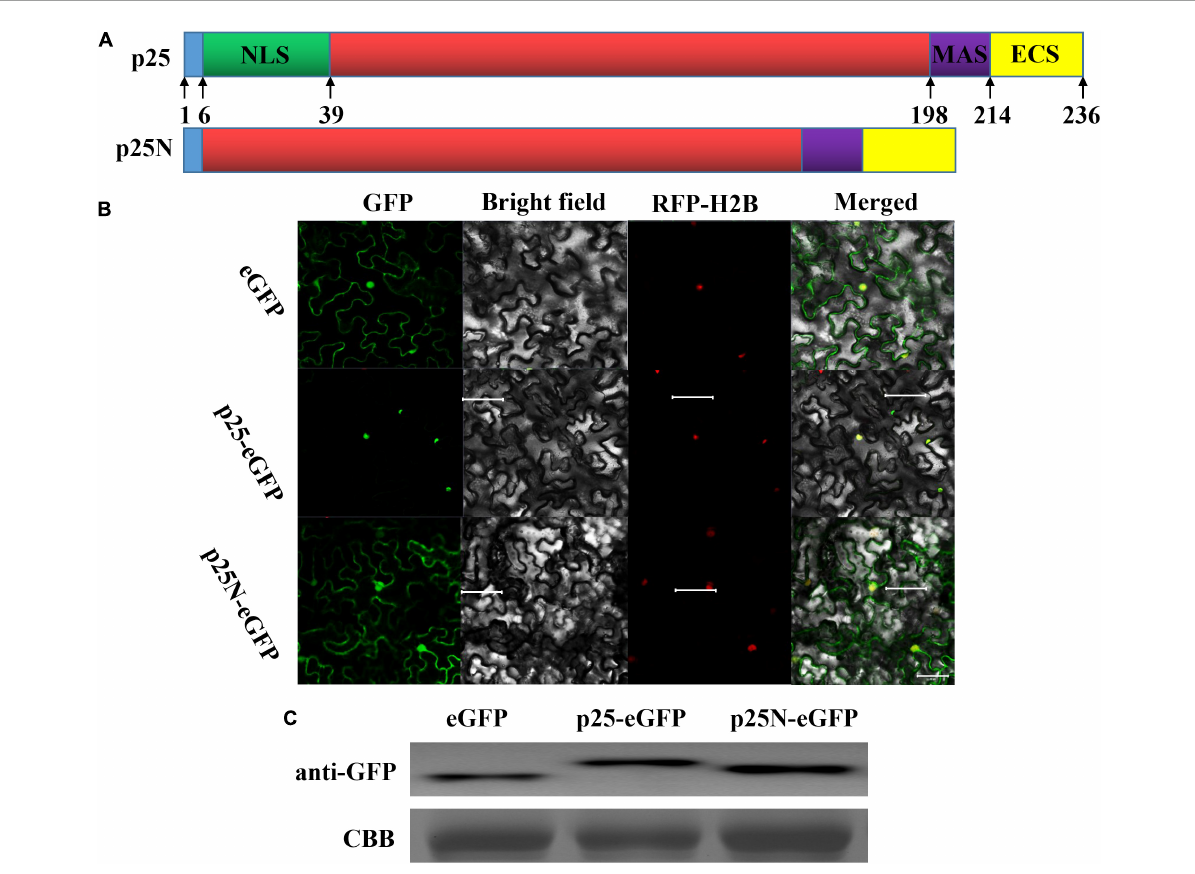
FIGURE3 Subcellular location of p25. (A) Schematic sketch of the construction strategies of p25 and p25N. p25, the whole open reading frame (ORF) of p25; p25N, the truncated sequence lacking the nuclear localization signal (NLS) (in green) of p25. (B) Confocal laser scanning micrographs of the location of p25 in Nicotiana benthamiana . The co-localization signal of RFP-H2B is shown as a positive nuclear control, and eGFP was used as a control located in the nucleus and cytoplasm. Scale bars: 50 µ m. (C) Western blot of eGFP, p25-eGFP, and p25N-eGFP using anti-GFP antibody. Coomassie brilliant blue-stained Rubisco protein (blue bands) was used as a total protein loading